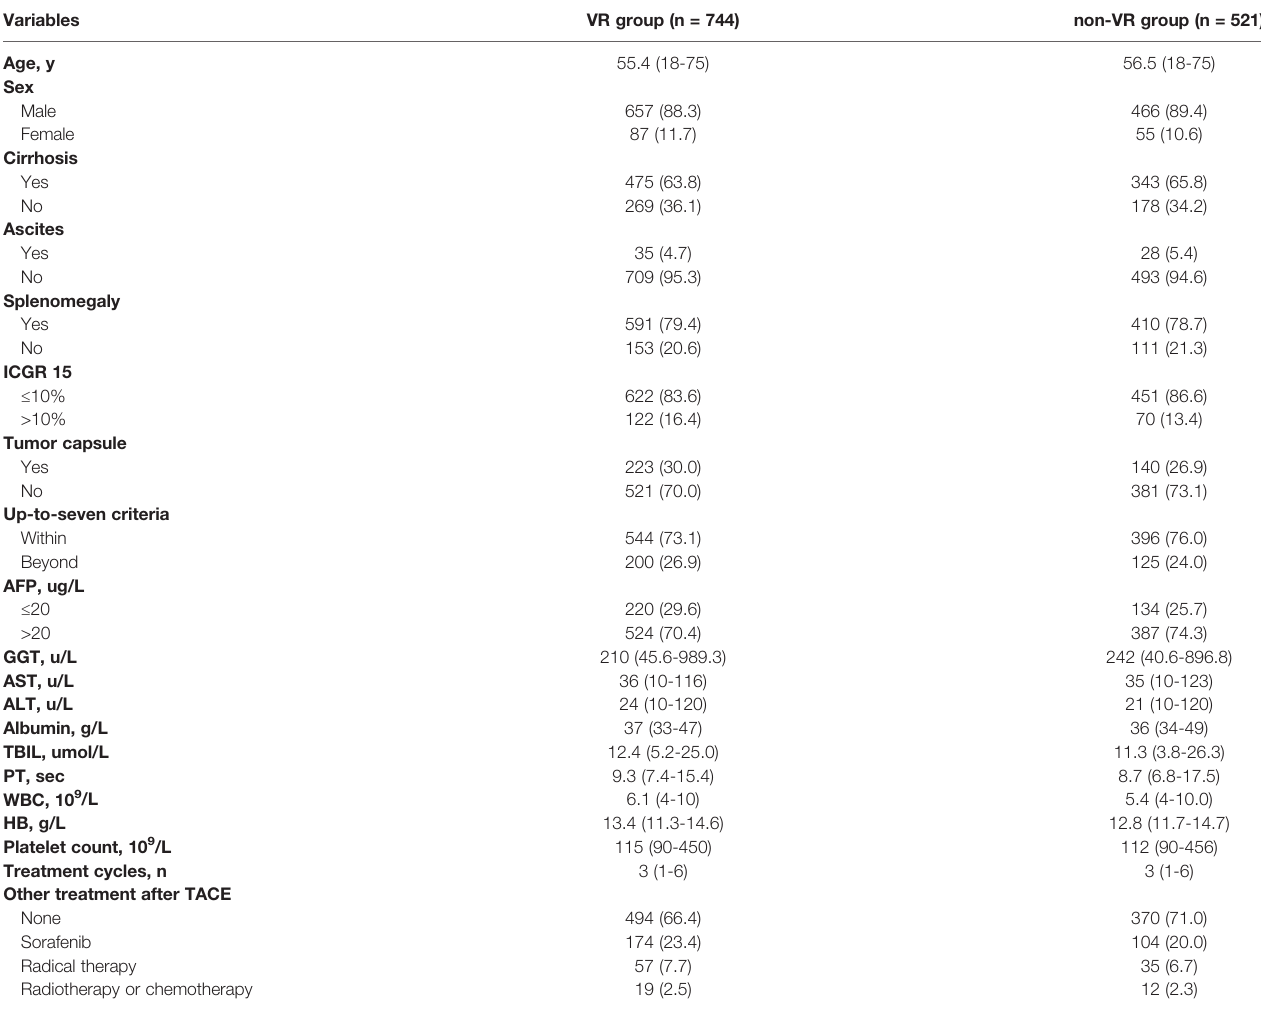
TABLE 1 | Baseline characteristics of patients received NA therapy (VR versus